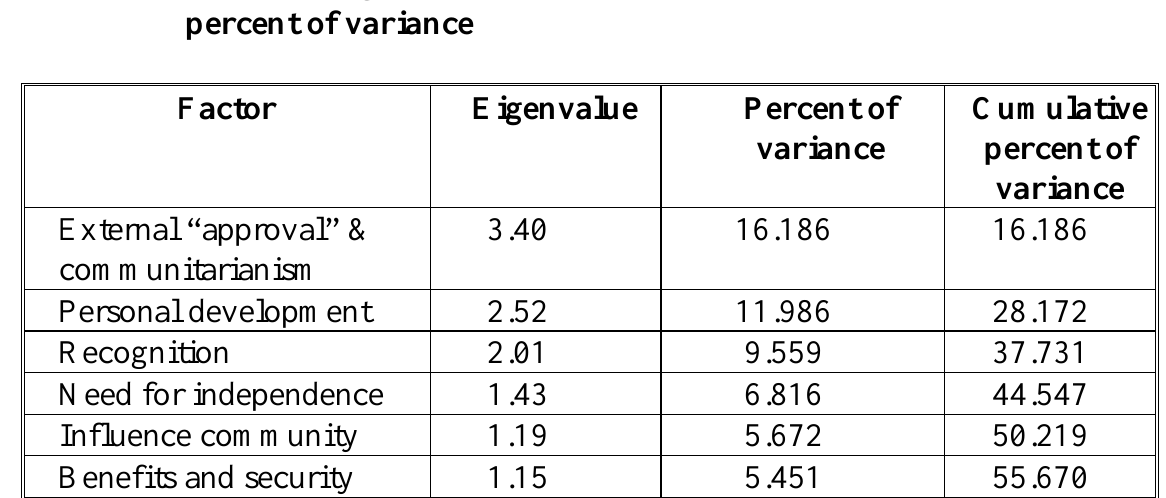
Table 3 Factors, eigenvalues, percent of variance and cumulative percent of variance Factor Eigenvalue Percent of